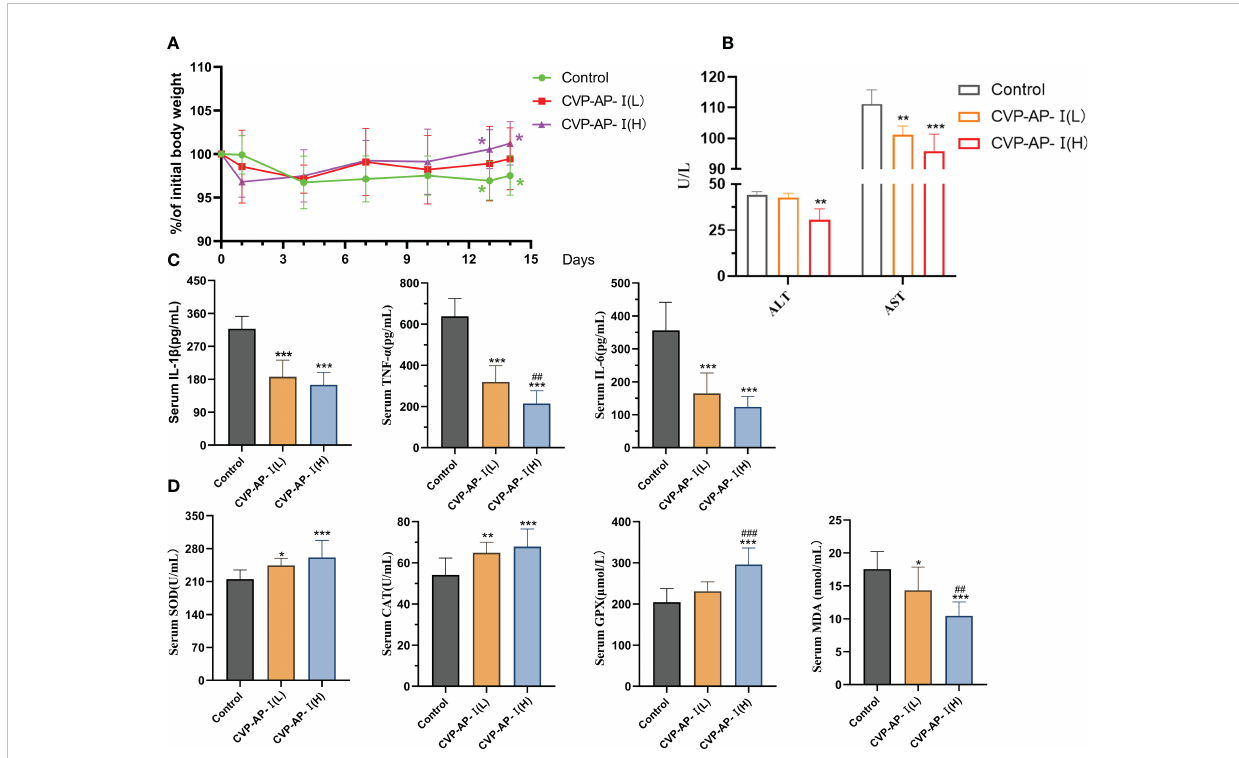
FIGURE 3 Effects of CVP-AP-I on body weight and serum levels of ALT, AST, pro-in fl ammatory factors (IL-6, IL-1 b , TNF- a ), antioxidant enzymes (SOD, CAT, GPX) and MDA in aging mice. (A) Changes in body weight of mice (Relative to initial body weight; n=10); (B) Quanti fi cation shows the serum levels of ALT and AST in the mice of different groups (n=4); (C) Quanti fi cation shows the in fl ammatory factor IL-1, TNF- a , IL-6 level in the serum from different groups mice(n=6). (D) Quanti fi cation shows the activity of the antioxidant enzymes SOD, CAT and GPX and the level of MDA in the serum of the mice in the different groups (n=6). All data are represented as means ± SD.* p <0.05, ** p <0.01, and *** p <0.001 as compared with Control Group. ## p <0.01 and ### p <0.001 as compared with CVP-AP-I (L)